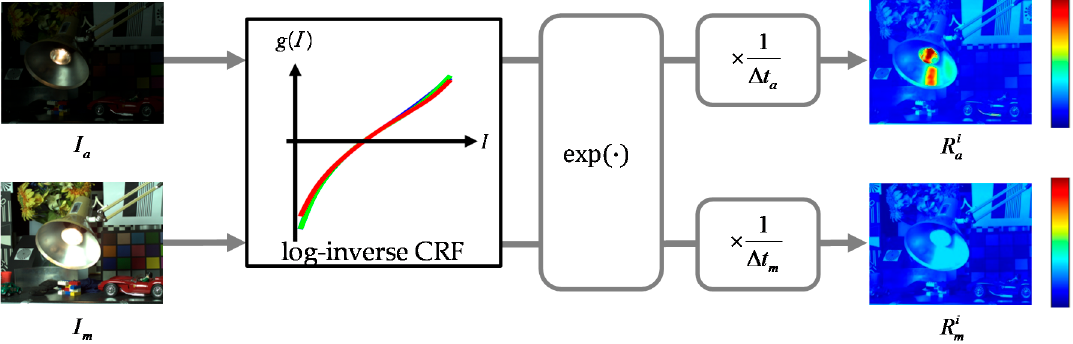
Figure 3. Radiance space conversion.